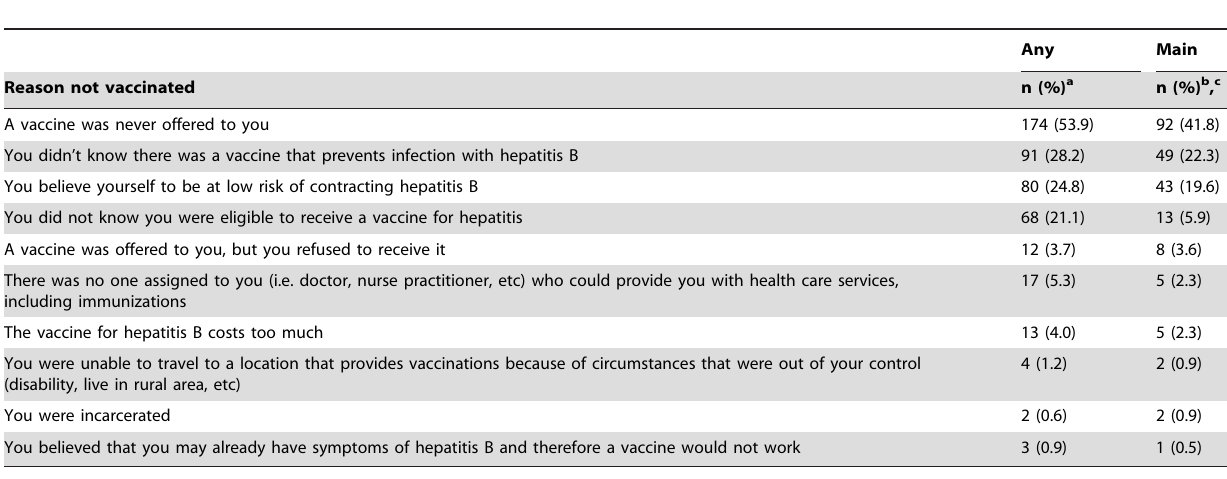
Table 1. Reasons for lack of hepatitis B vaccination among 323 unvaccinated, HIV- and hepatitis B-negative men who have sex with men, United States, October–December